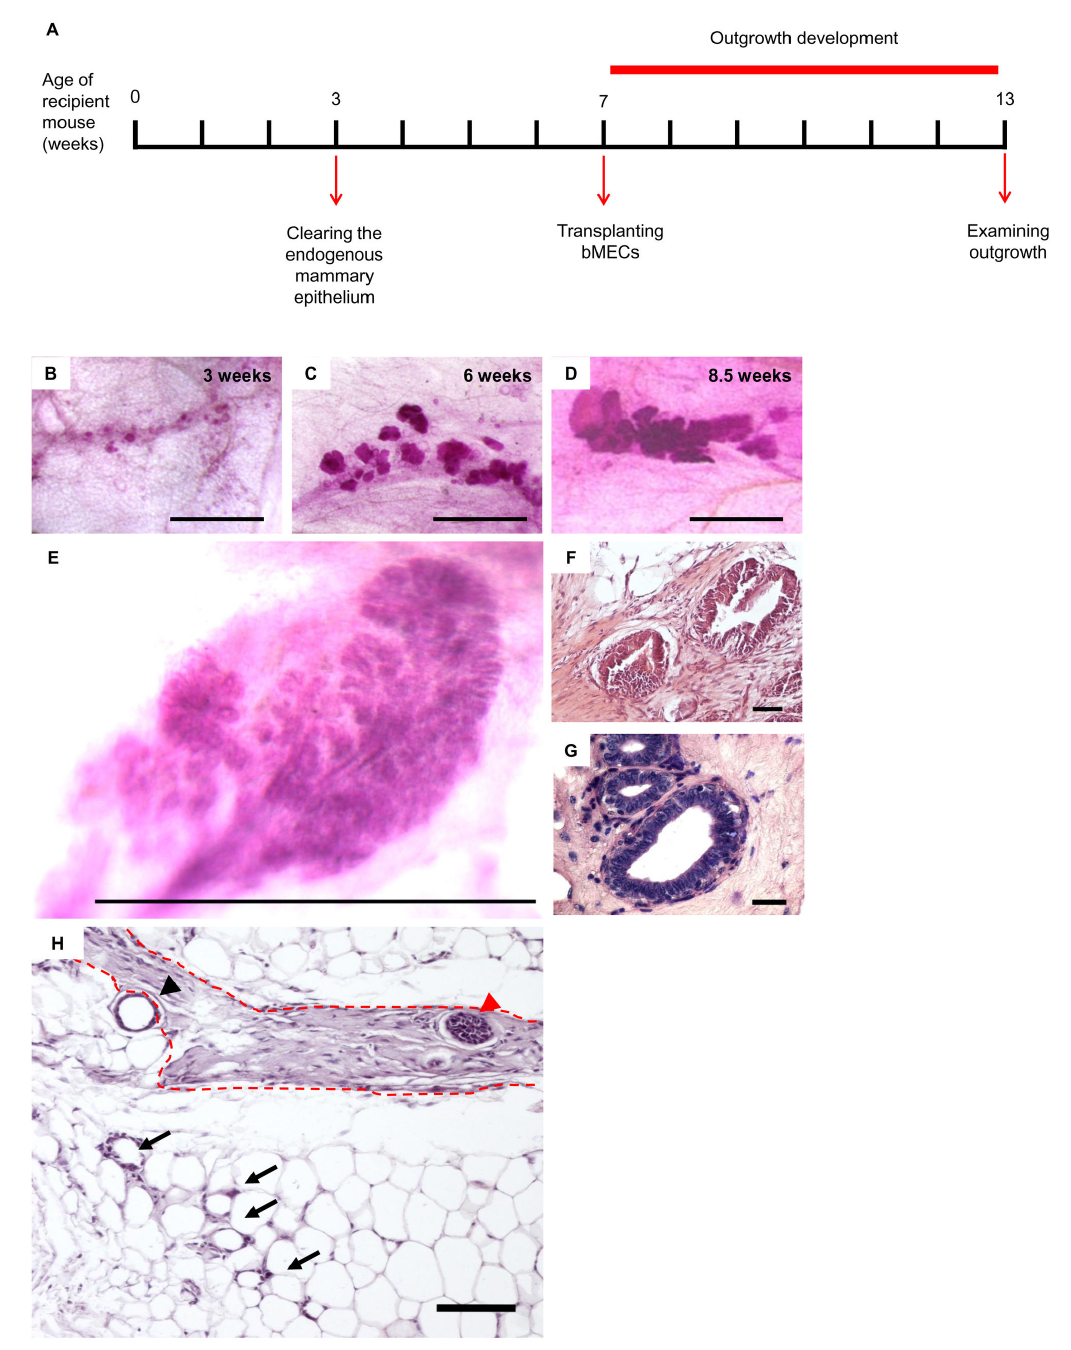
Figure 1. Transplanted bMECs generate developing spherical outgrowths in the mouse mammary fat pad with location- dependent morphology. A : Timeline of basic transplantation procedure. B – D : Carmine-stained wholemounts depicting typical outgrowth development at, respectively, 3, 6 and 8.5 weeks after cell transplantation. Bar = 1 mm. E : Carmine-stained wholemount of biopsy from the parenchymatic region of the heifer’s mammary gland. Bar = 1 mm. F : H&E-stained paraffin section from a Carmine-stained wholemount of 6-week-developed outgrowth. Bar = 50 µm. G : H&E-stained paraffin section from the parenchymatic region of a heifer’s mammary gland. Bar = 25 µm. H : H&E-stained paraffin section from a region containing outgrowths. A fibrous stromal area (dashed red line) encloses a solid, multilayered spherical outgrowth (red arrowhead) and partially encloses a hollow single-layered outgrowth (black arrowhead). Arrows indicate disorganized epithelial cells embedded in the adipose stroma. Bar = 100 µm. doi: 10.1371/journal.pone.0068637.g001 PLOS ONE |